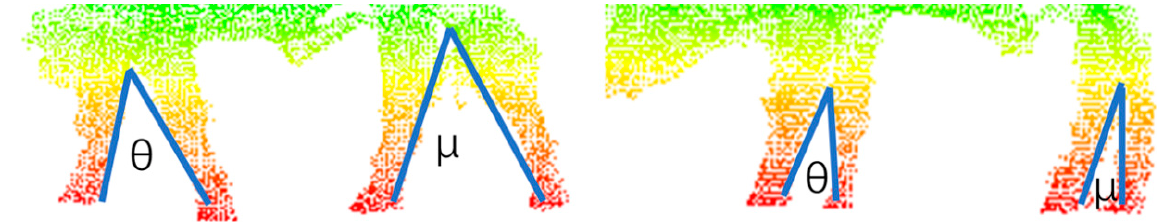
Figure 18. The extraction of bifurcation angles.